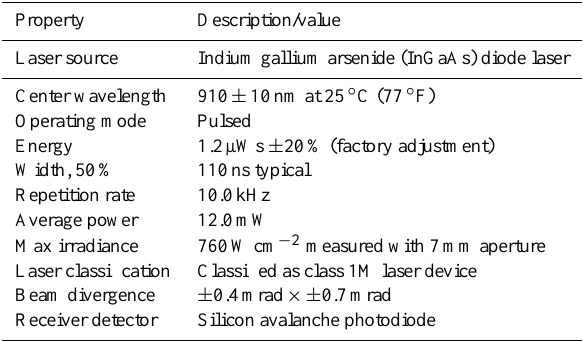
Table 1. Technical specification of Ceilometer